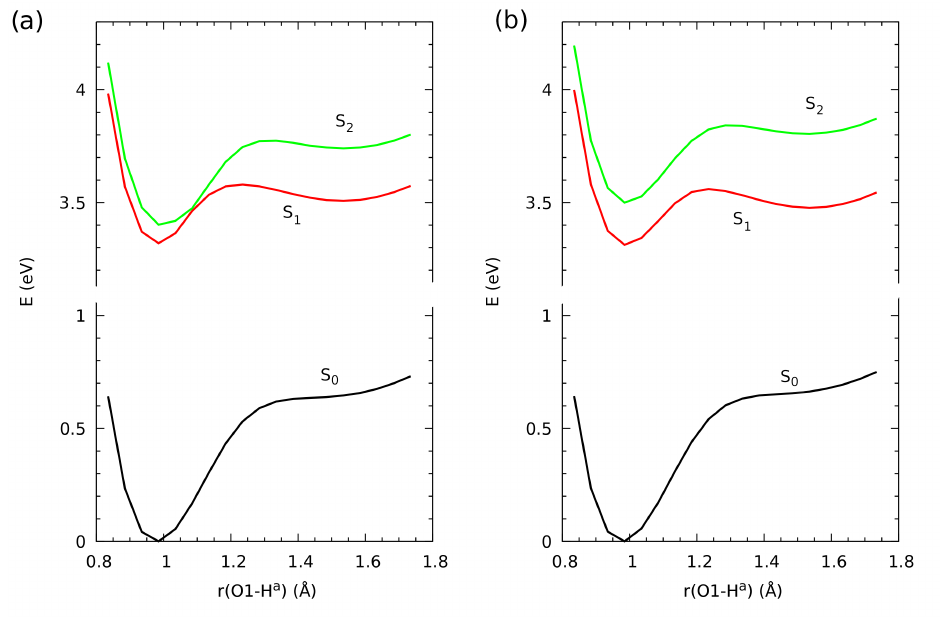
Figure 7. The proton potential functions for the proton transfer pathway in the ground electronic state and two lowest-lying excited singlet states from TD-DFT calculations at the ω B97XD/6-311+G(d,p) level. ( a ) Results for compound 2 , 1,8-dihydroxy-9,10-anthraquinone. ( b ) Results for compound 3 ,